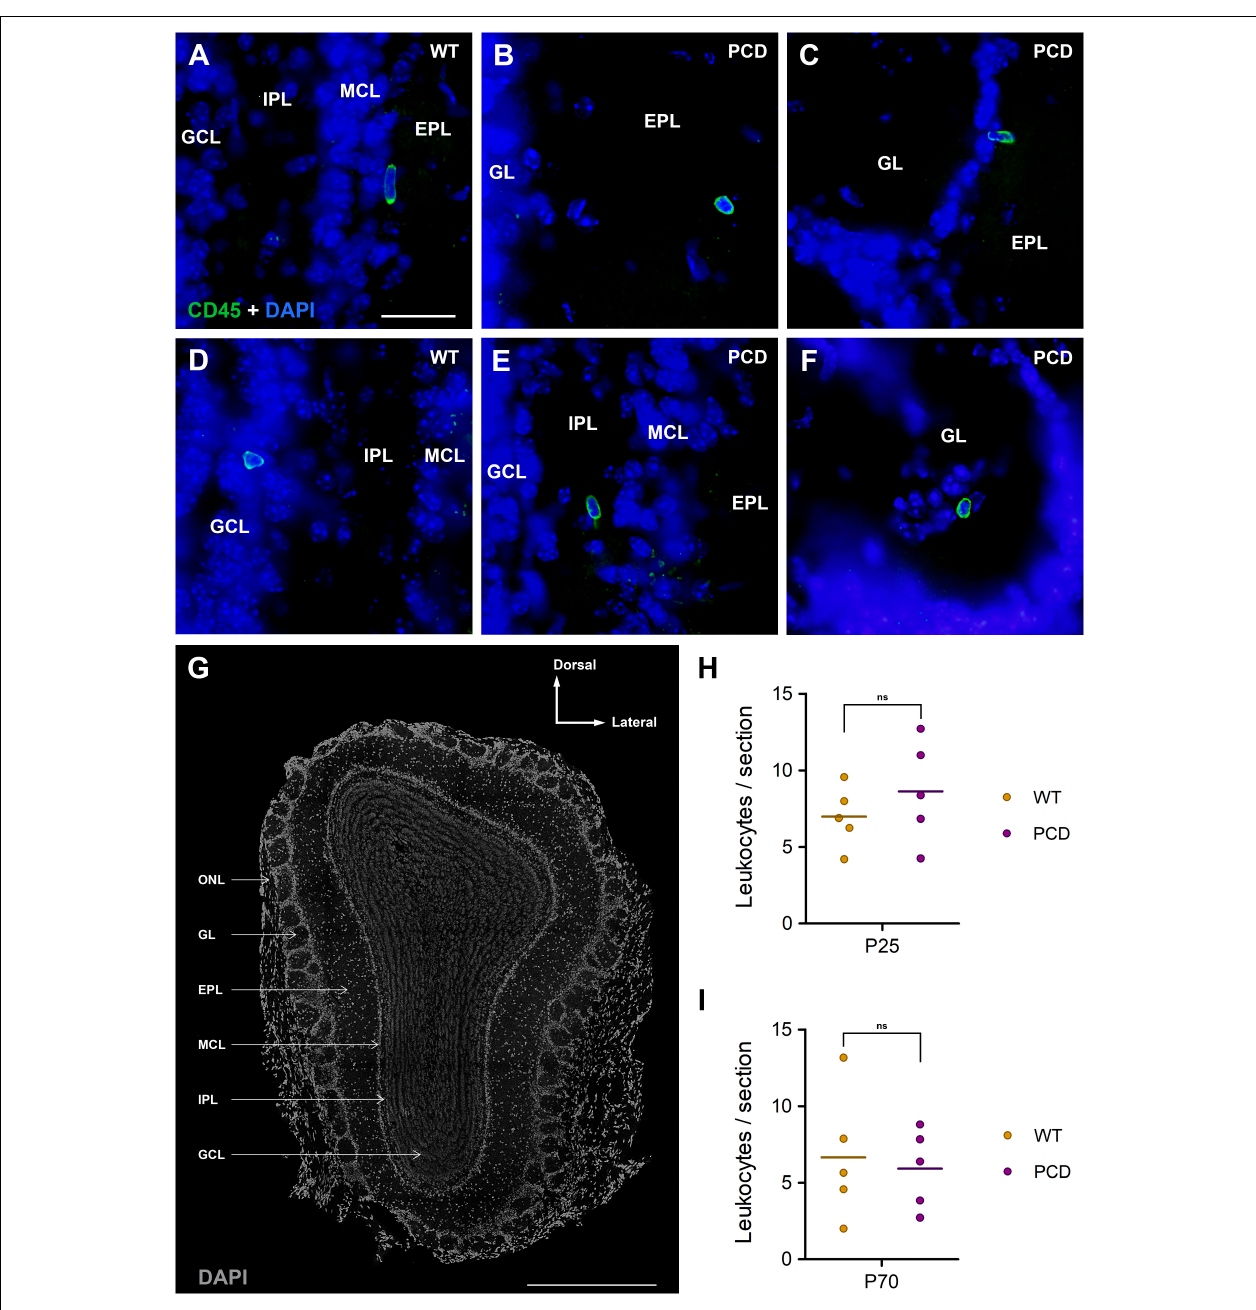
FIGURE 1 | Leukocyte infiltration into the OB of WT and PCD mice. (A–F) Immunolabeling for CD45 (green) showing leukocytes in the different layers of the OB of both WT and PCD mice; nuclei are stained with DAPI (blue). (G) Typical coronal section of the mouse OB obtained with confocal microscopy; nuclei are stained with DAPI (gray). (H,I) Charts showing the quantification of leukocytes per OB section at P25, when the death of mitral cells has not started in PCD mice, and at P70, when the mitral cell loss is in progress. No differences were detected between WT and PCD mice in any case. Data are expressed as dot plots, where each dot represents one individual animal and horizontal lines represent the mean of each group. GL, glomerular layer; EPL, external plexiform layer; MCL, mitral cell layer; IPL, internal plexiform layer; GCL, granule cell layer; ONL, olfactory nerve layer. ns, not significant ( p > 0.05). Scale bar: 25 µ m for (A–F) ; 500 µ m for (G)